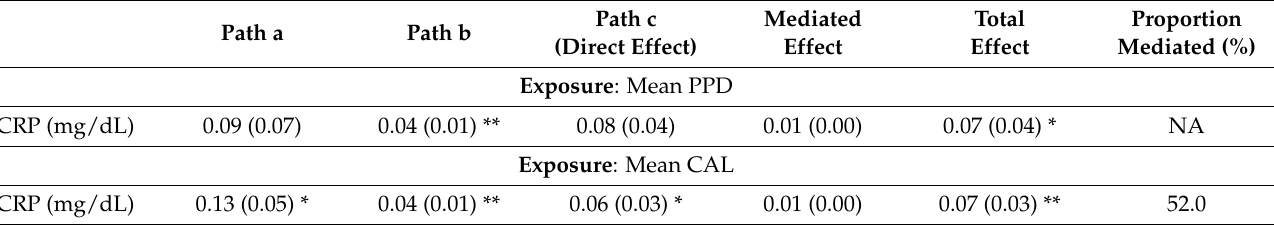
Table 5. Mediation analysis of the effects of systemic inflammatory elements on the association of periodontal measures (mean PPD and mean CAL–Exposures) with C-reactive protein ( n = 3238). Path a Path